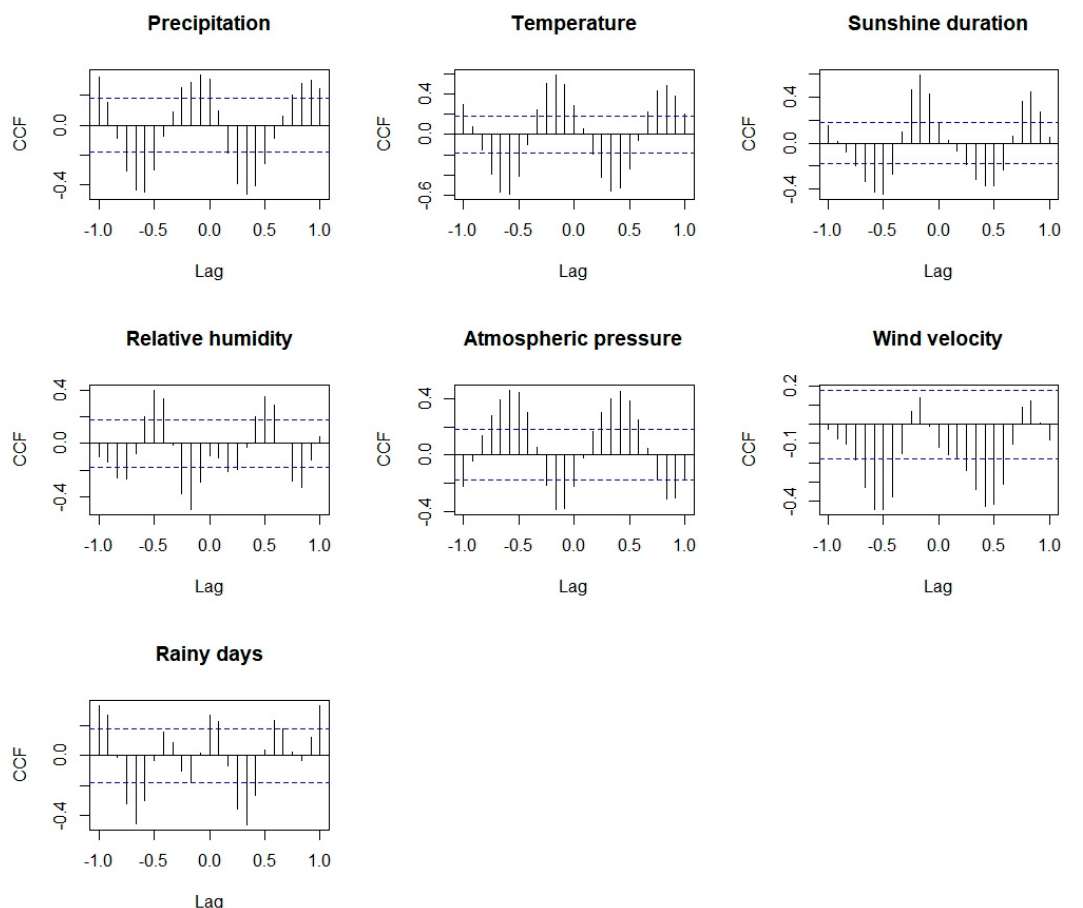
Figure 4. Cross–correlation between mumps and meteorological factors.